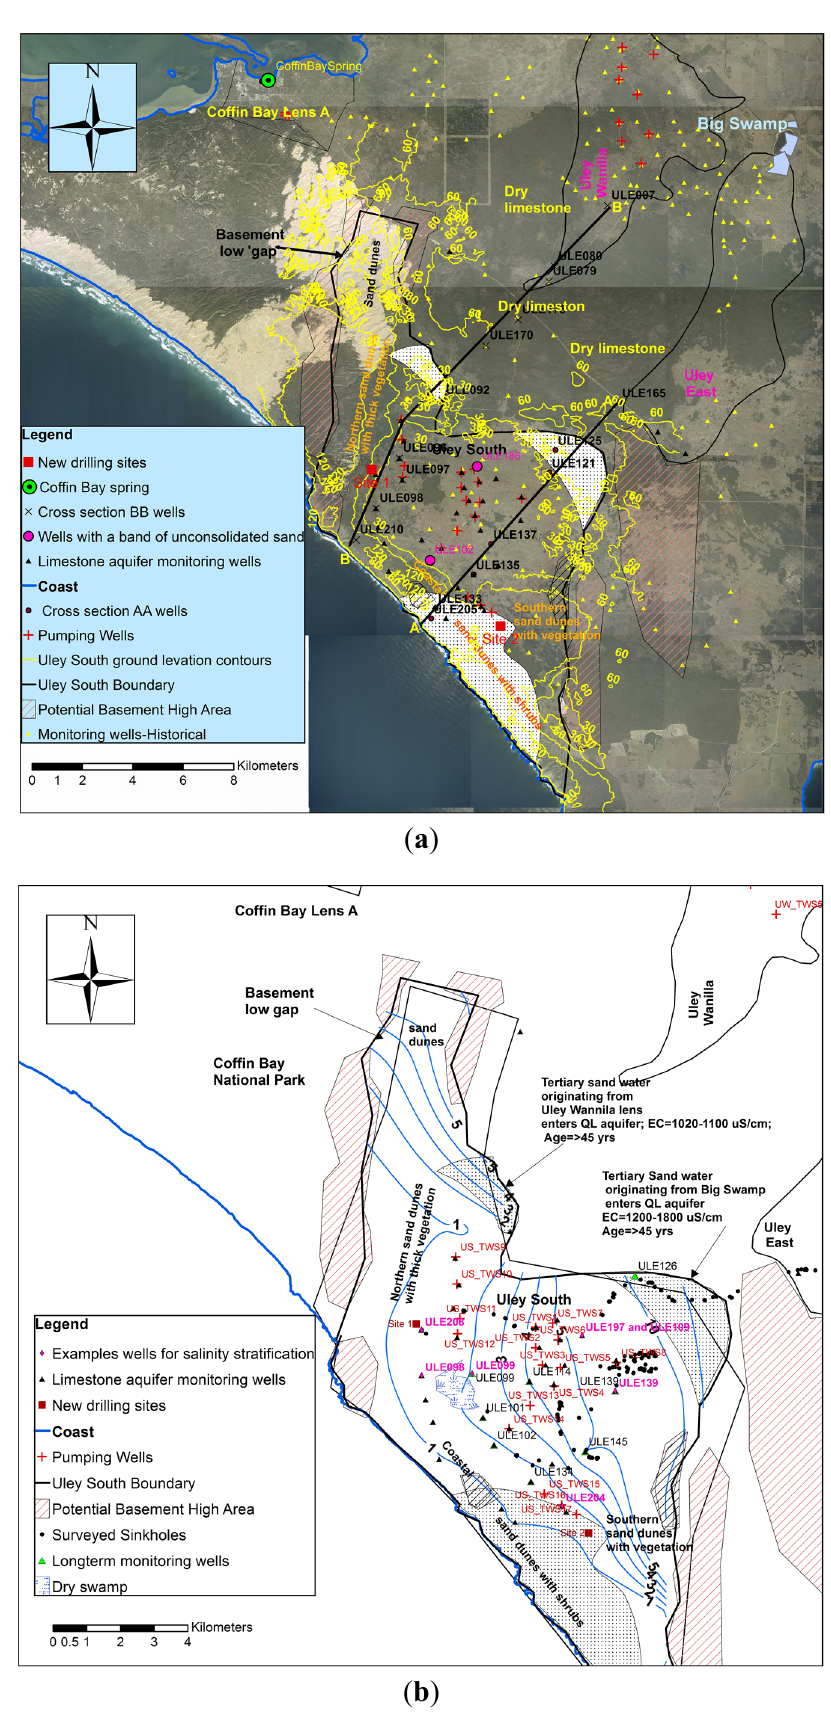
Figure 1. Uley South basin features ( a ) Topographic features ( b ) Groundwater elevations